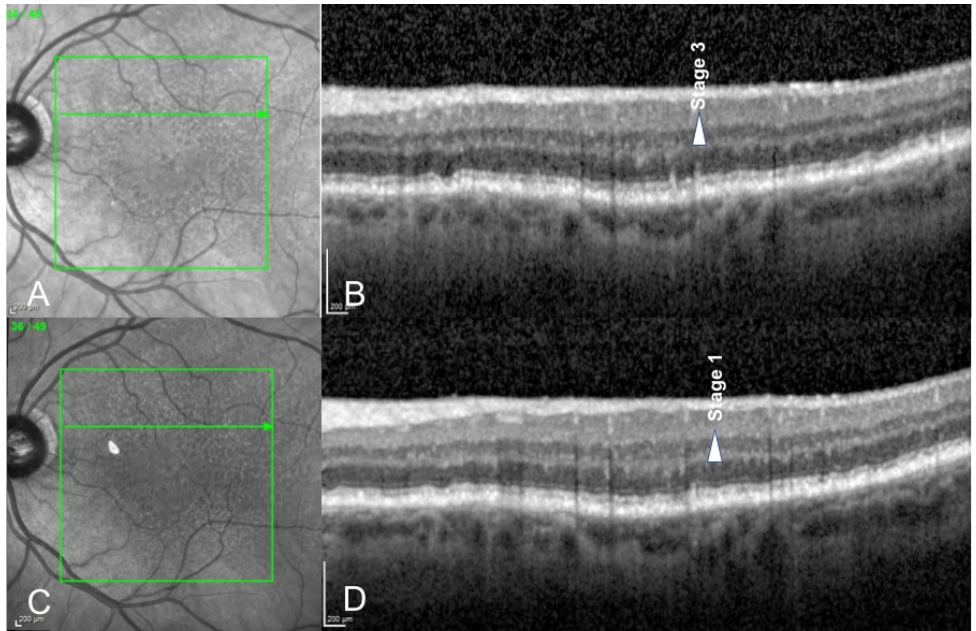
Figure 3. Spectral Domain Optical Coherence Tomography (SD-OCT) scans of a 76-year-old male patient before ( A , B ) and 6 months after photobiomodulation treatment ( C , D ). We can observe that a stage 3 reticular pseudodrusen (arrow, ( B )) regressed into a stage 1 reticular pseudodrusen (arrow, ( D )) after photobiomodulation